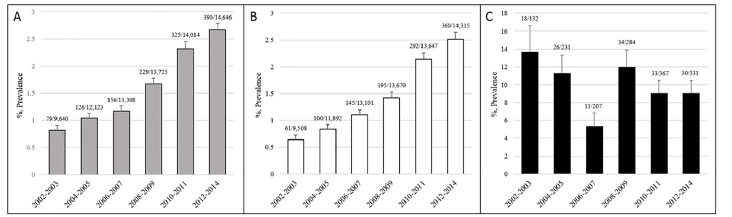
Fig 2. Trends in prevalence of candida esophagitis, 2002 – 2014. (A) All subjects, (B) non-HIV-infected patients, (C) HIV-infected patients. Values on bars are number of subjects testing positive/total number tested. Error bars show 95% confidential